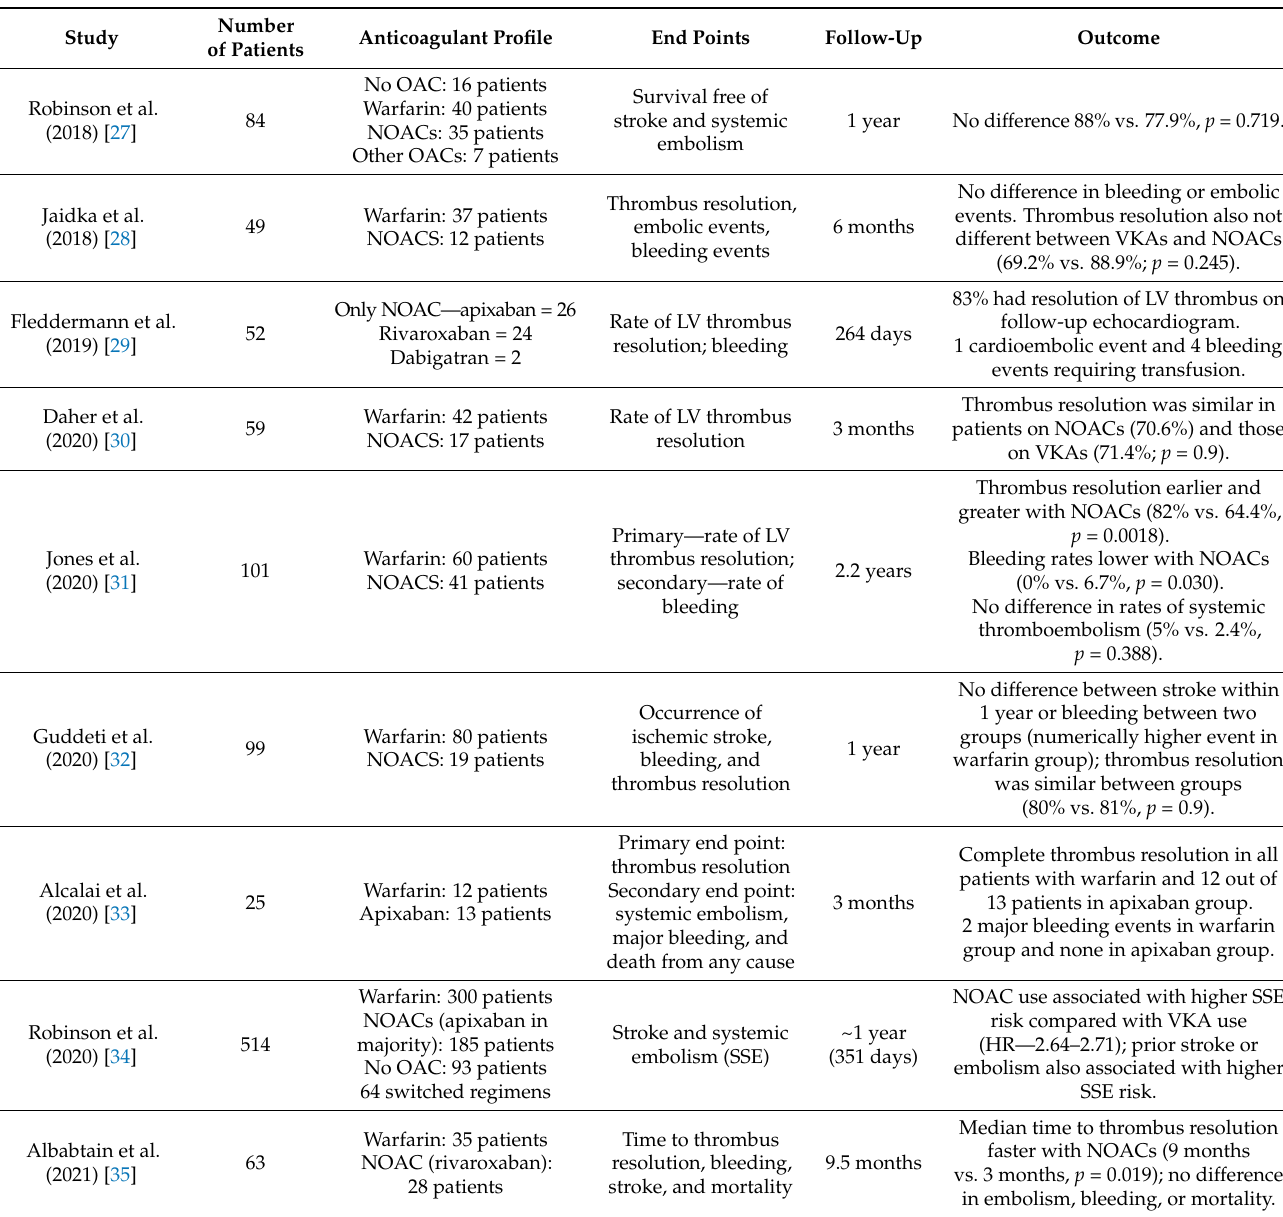
Table 2. Data from observational studies comparing anticoagulation with DOACs vs. VKAs in patients with LV thrombus. Notes: DOAC—direct oral anticoagulant; OAC—oral anticoagulant; VKA—vitamin K antagonist; LV—left ventricle; HR—hazard